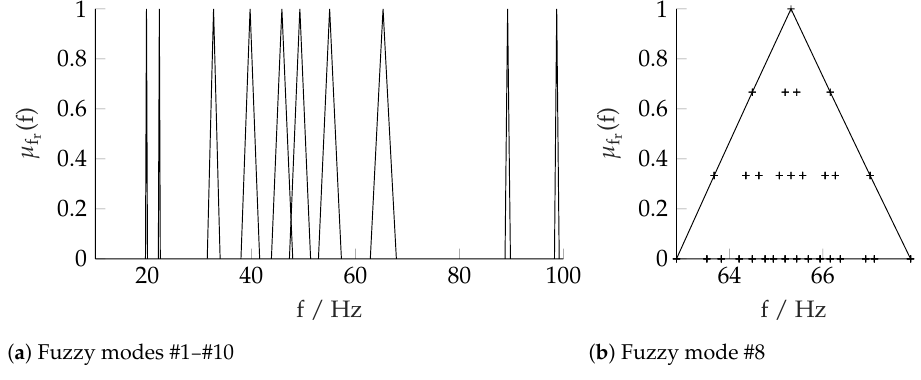
Figure 6. A detailed look on modes #1 - #10